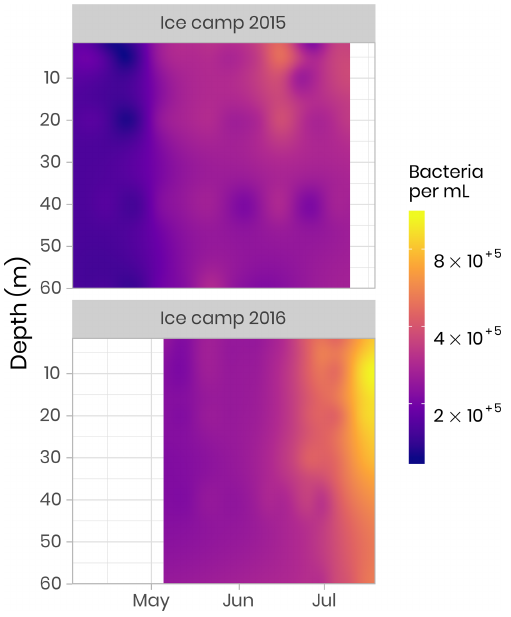
Figure 9. Concentration of bacteria in the water column at the ice camp in 2015 and